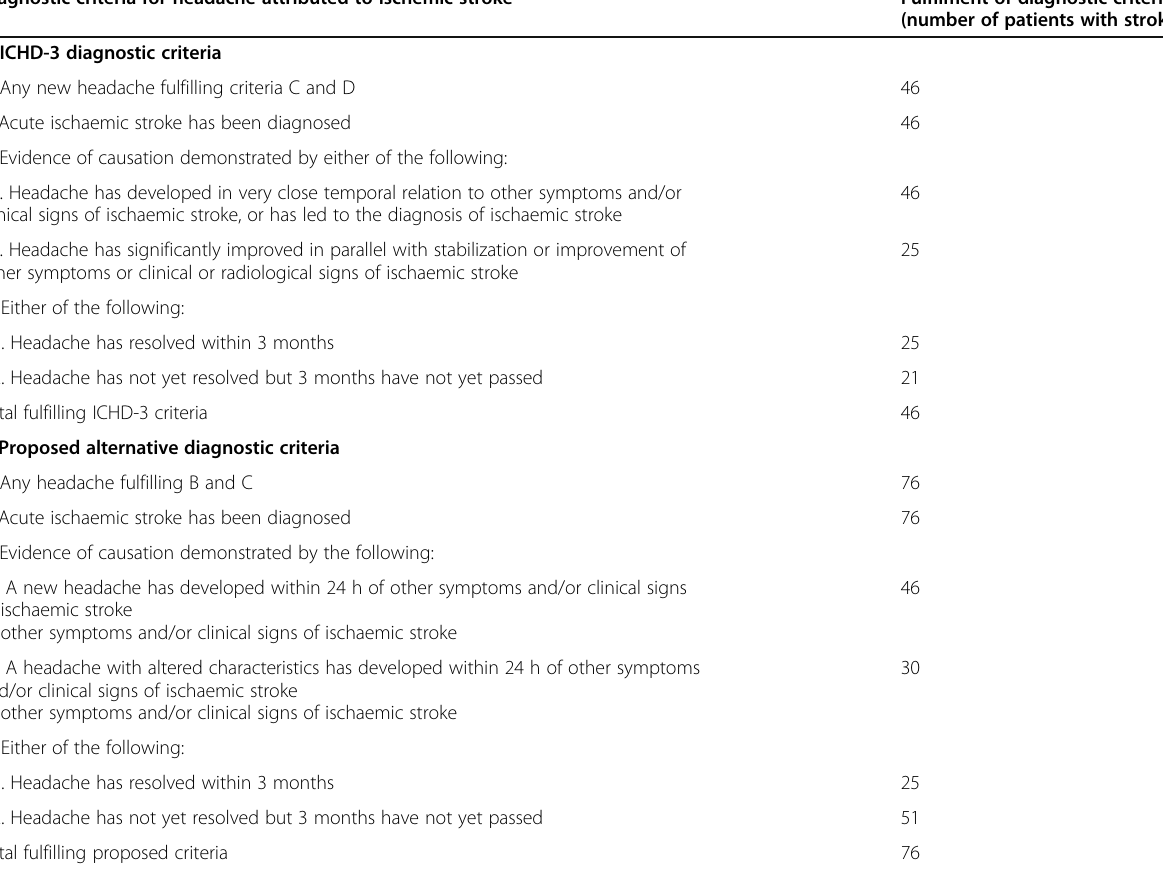
Table 4 Fulfilment of ICHD-3 diagnostic subcriteria and proposed subcriteria for headache attributed to ischemic